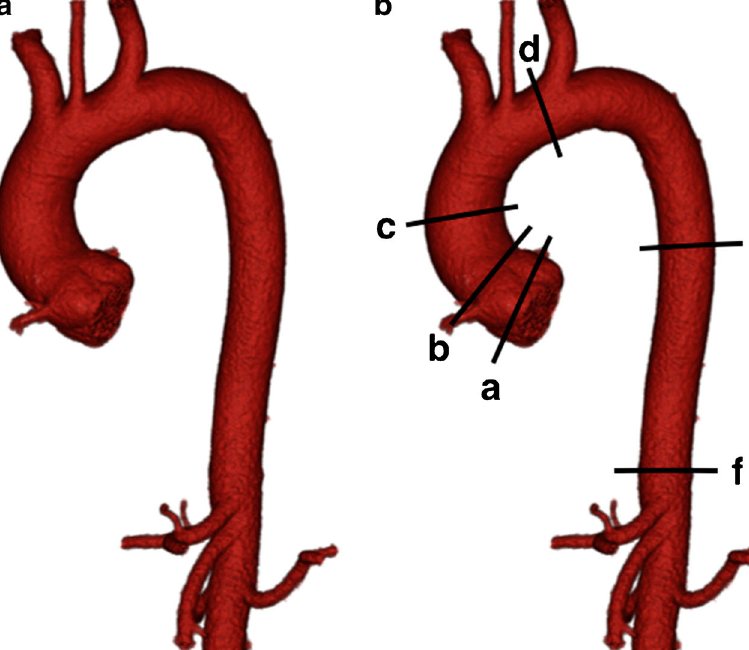
a CTA with additional 70 s delayed phase imaging (Table 1) can assess both the size of the excluded aneurysm and for the presence of an endoleak (Fig. 8) [74, 75]. This identical pro- tocol can also be used to assess for the presence of active bleeding, with the arterial and delayed phases demonstrating active extravasation, and can help triage patients for IR Fig. 4 a Three-dimensional seg- mented VR image of the abdom- inal aorta with b standard sites of measurement. a Proximal ab- dominal aorta, b juxtarenal ab- dominal aorta, c infrarenal ab- dominal aorta, d right common iliac artery, e left common iliac